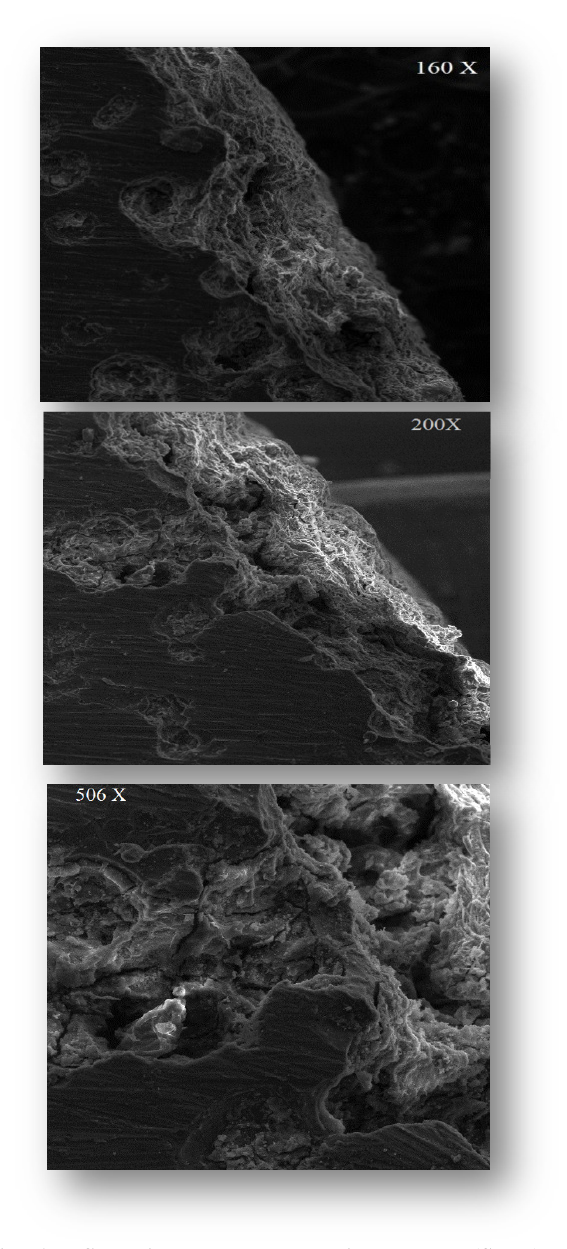
Fig.13. Scanning Electron Microscope (SEM) images of deposited aluminum produced by Electro- refining